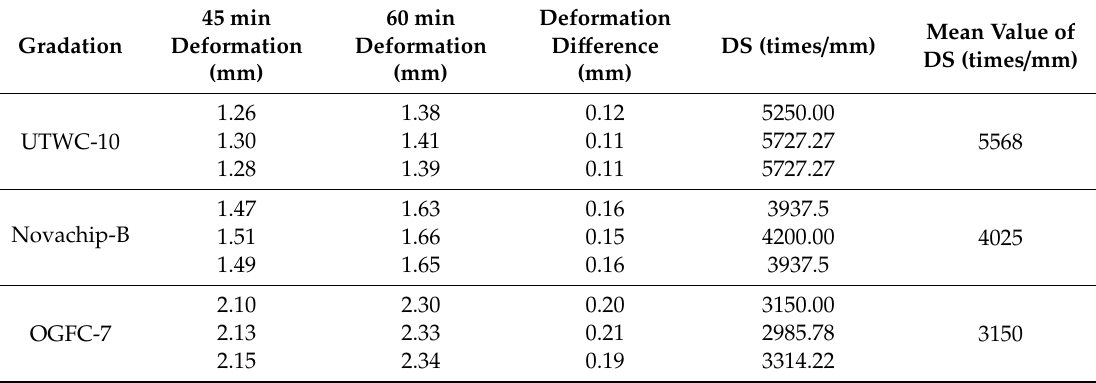
Table 6. The high-temperature rutting test results of the three asphalt